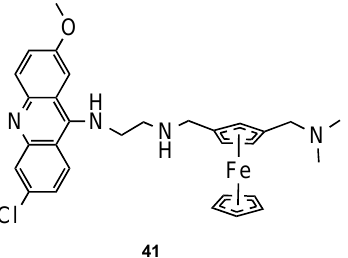
Figure 27. Ferrocene – acridine hybrid 41 developed by Blackie and co-workers [59].